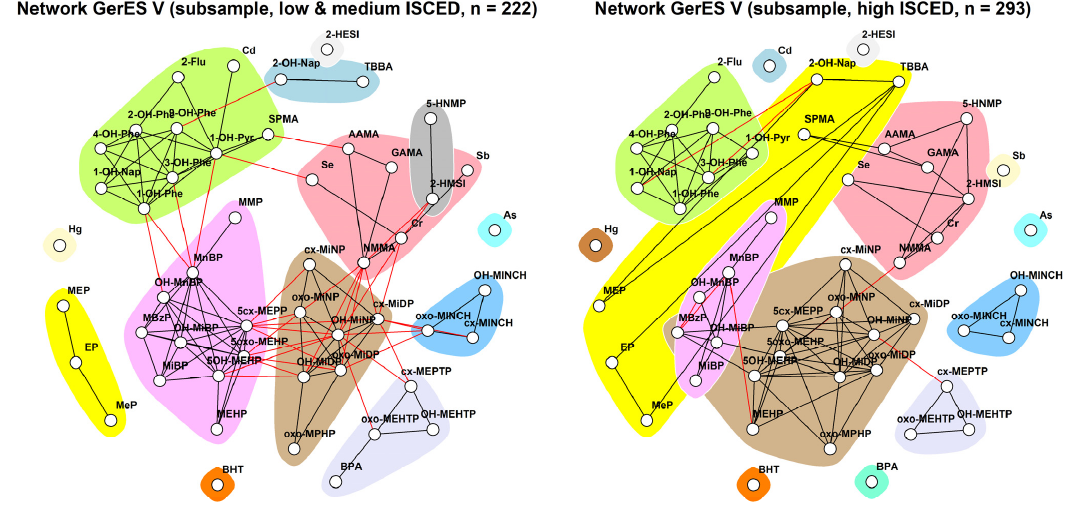
Figure 11. Stratification of the network for the GerES V subsample by education (ISCED), using creatinine-standardised and creatinine-adjusted data. Data were corrected for sex, smoking status, age, and BMI. Low ISCED reflects educational levels 0–4 from the ISCED (International Standard Classification of Education) and high ISCED reflects educational level ≥ 5. Black lines indicate dependency between nodes (biomarkers) within a community; red lines indicate dependency between nodes in different communities.